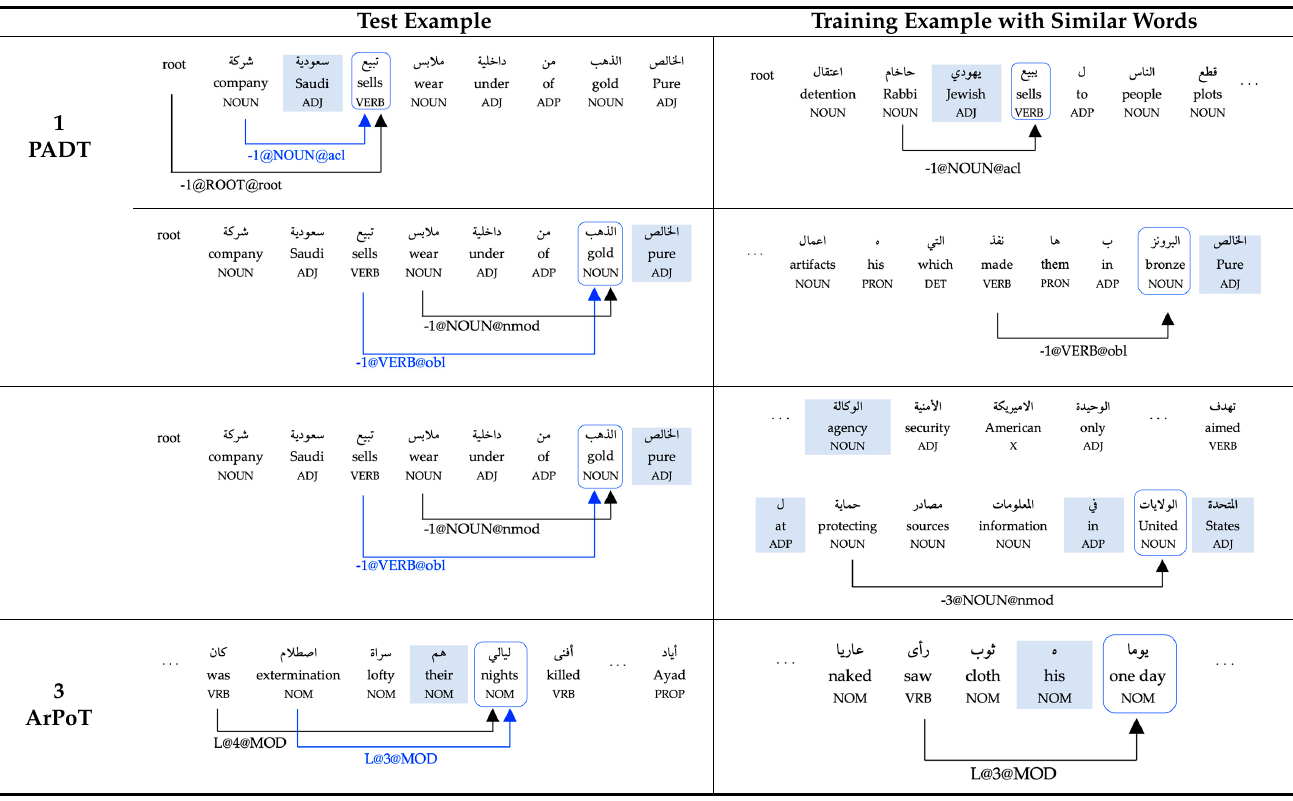
Table 17. Examples from the PADT and ArPoT test data that show the effect of contextualized embeddings using obverse-related training sentences. Correct arrows are black, whereas blue arrows indicate wrong assignments. Rectangles enclose the test tokens with incorrect predictions and similar words in the training sentences. In both sentences, the other comparable words in the sequence are shaded.